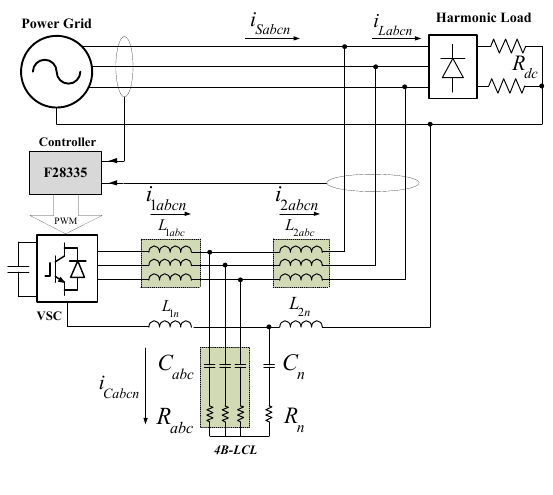
Figure 14. Experimental